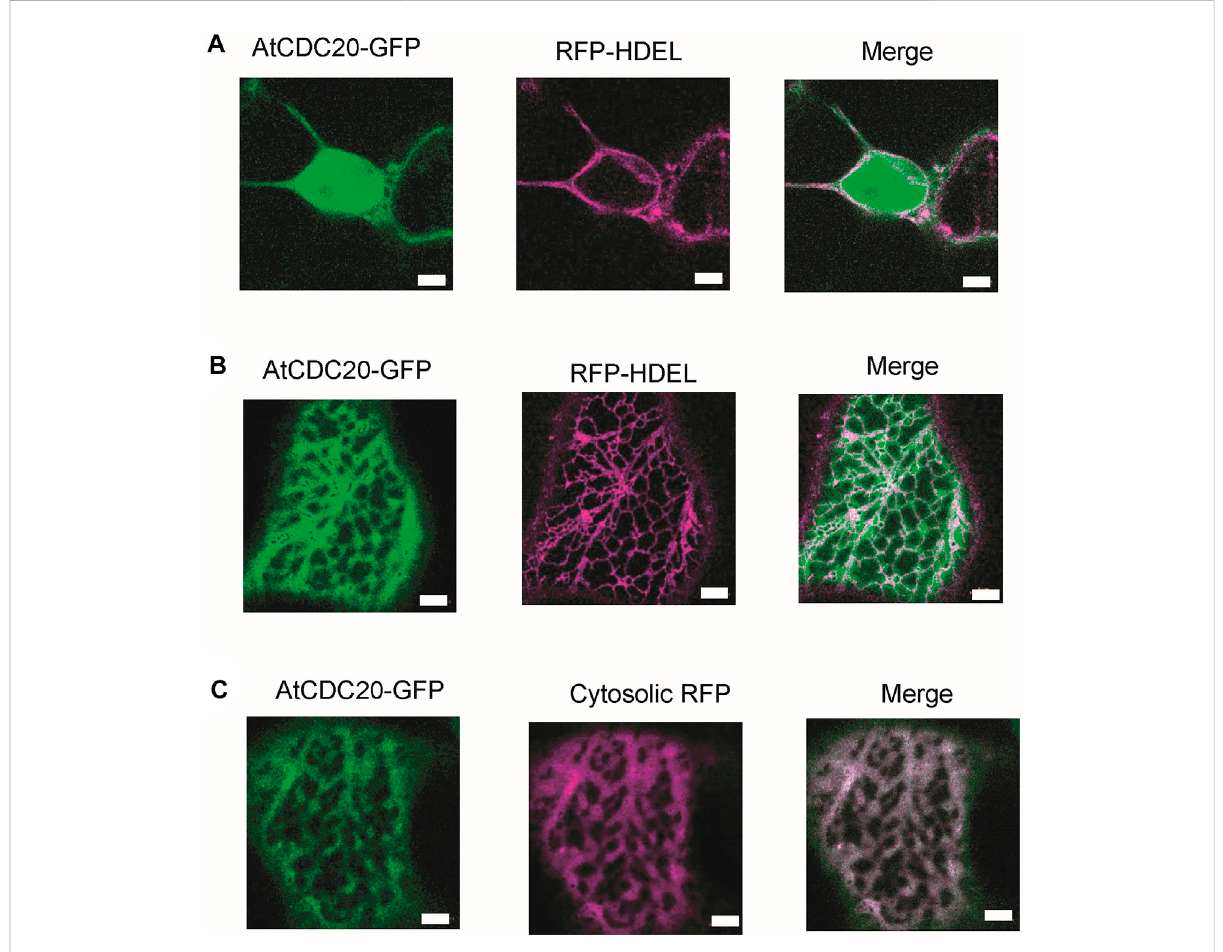
FIGURE 5 AtCDC20.1 subcellular localisation. AtCDC20-GFP together with suborganellar markers is transiently expressed in tobacco leaf epidermal cells via Agrobacterium-mediated gene expression. AtCDC20.1-GFP is co-expressed with the ER lumenal marker RFP-HDEL and visualised on the nucleus (A) , showing labelling in the nucleoplasm and ER (B) . AtCDC20.1-GFP co-localises with free RFP labelling the cytosol (C) . Example images from n = 3 with at least 5 technical replicas each. Size bars = 5